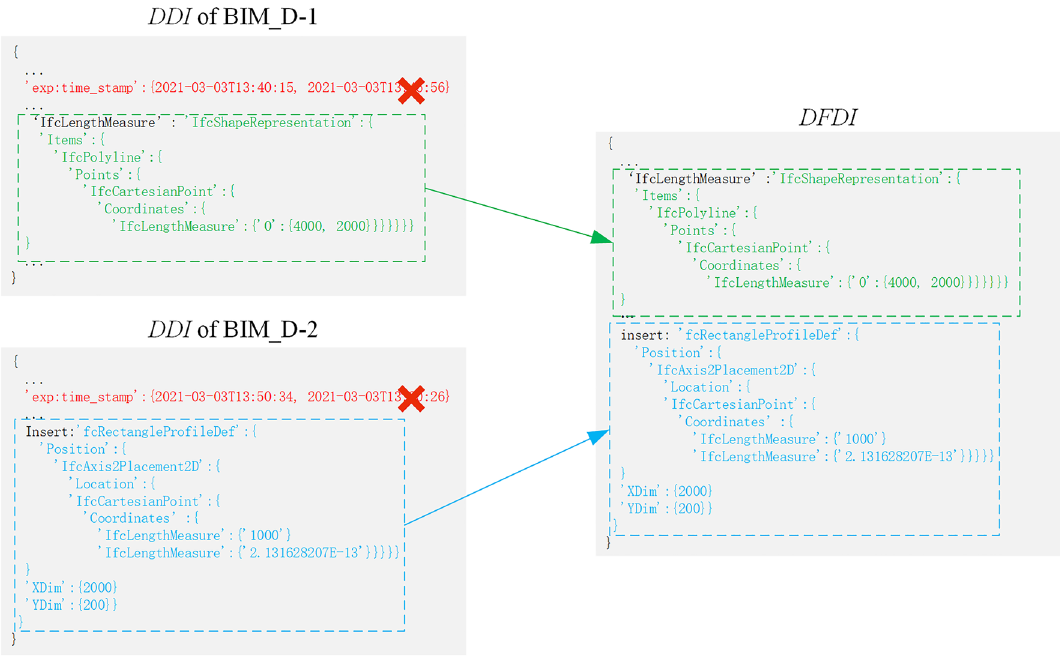
Figure 11. BIM drawing design information fusion